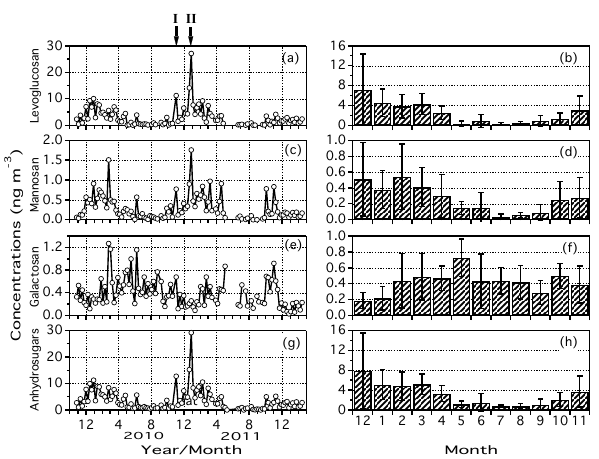
Figure 3. Temporal variation (a, c, e, g) and monthly means (b, d, f, h) of anhydrosugars in aerosols at Cape Hedo, Okinawa, from October 2009 to February 2012. Typical elevation events of anhy- drosugars are marked I and II and analyzed in